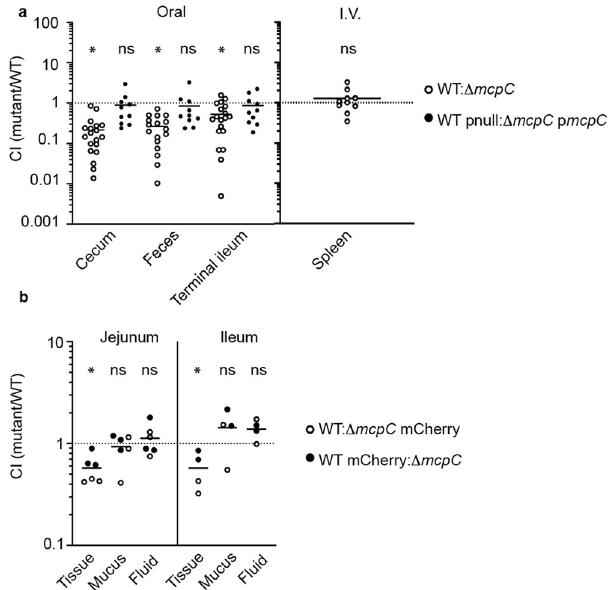
Fig. 5 McpC contributes to invasion in the gastrointestinal tract.